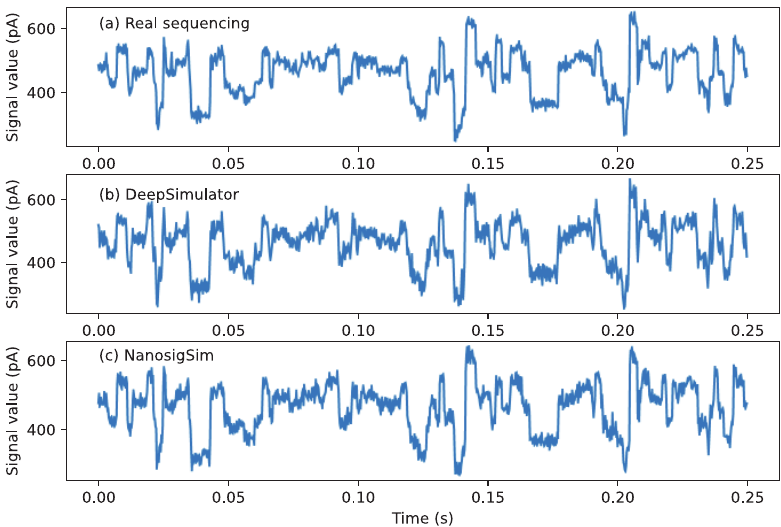
Figure 8. The comparison between: ( a ) the real sequencing signal waveform; ( b ) the simulated signal waveform from DeepSimulator; and ( c ) the simulated signal waveform from NanosigSim. The simulated signals from both DeepSimulator and NanosigSim are similar to the real sequencing signal.